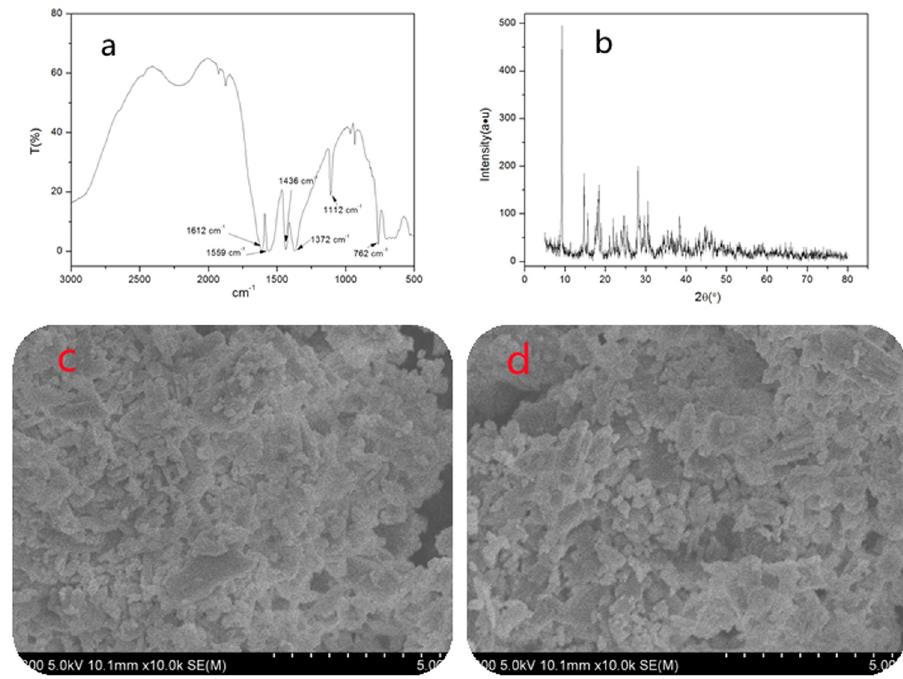
Figure 1: Structural characterization of Sm - MOFs: ( a ) FTIR, ( b ) XRD, and ( c and d ) SEM.